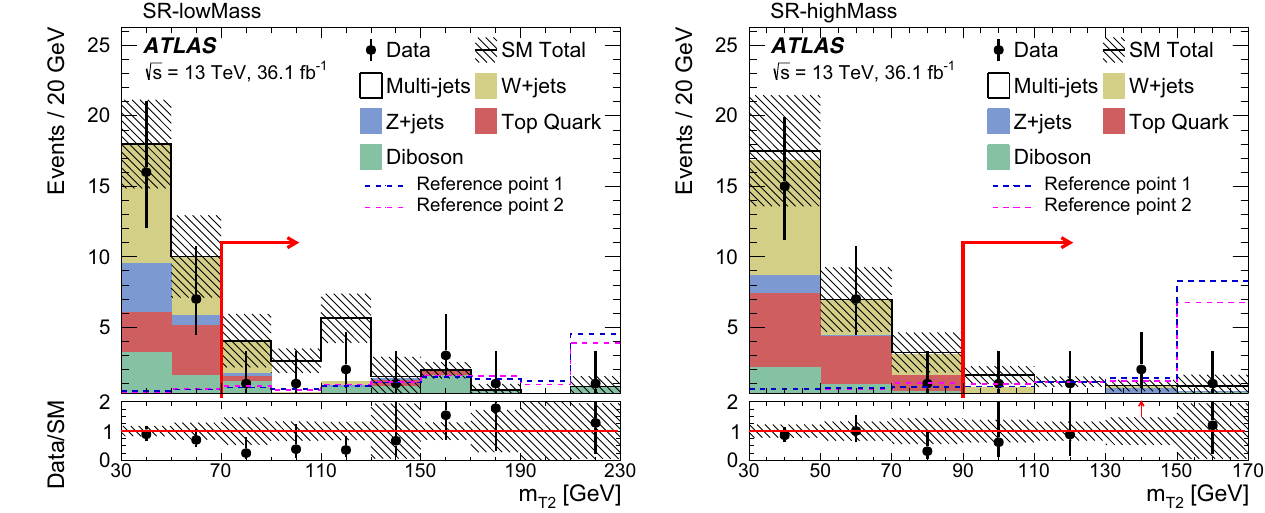
malisation factors. The hatched bands represent the sum in quadrature of systematic and statistical uncertainties of the total SM background. For illustration, the distributions of the SUSY reference points (defined in Sect. 3) are also shown as dashed lines. The lower panels show the ratio of data to the total SM background estimate. The last bin includes the overflow